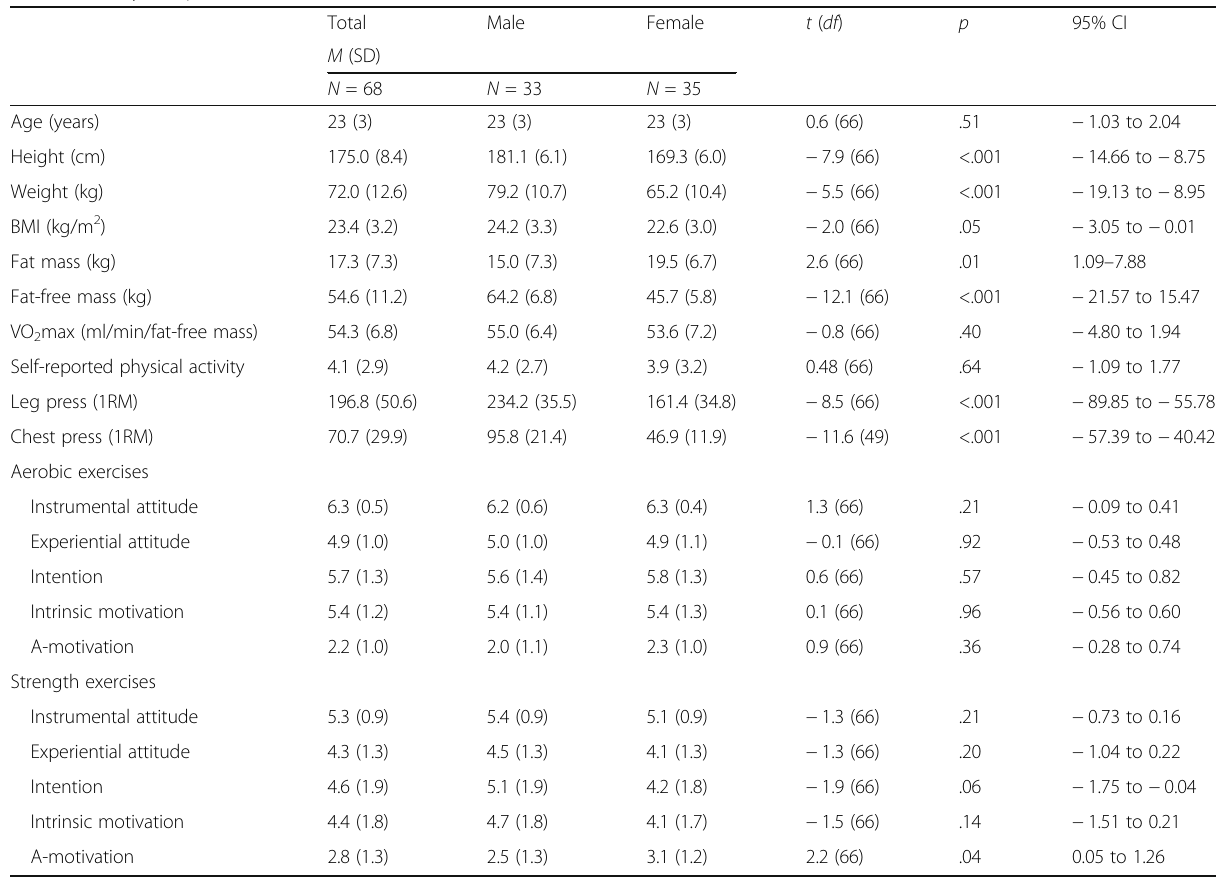
Table 2 Study sample